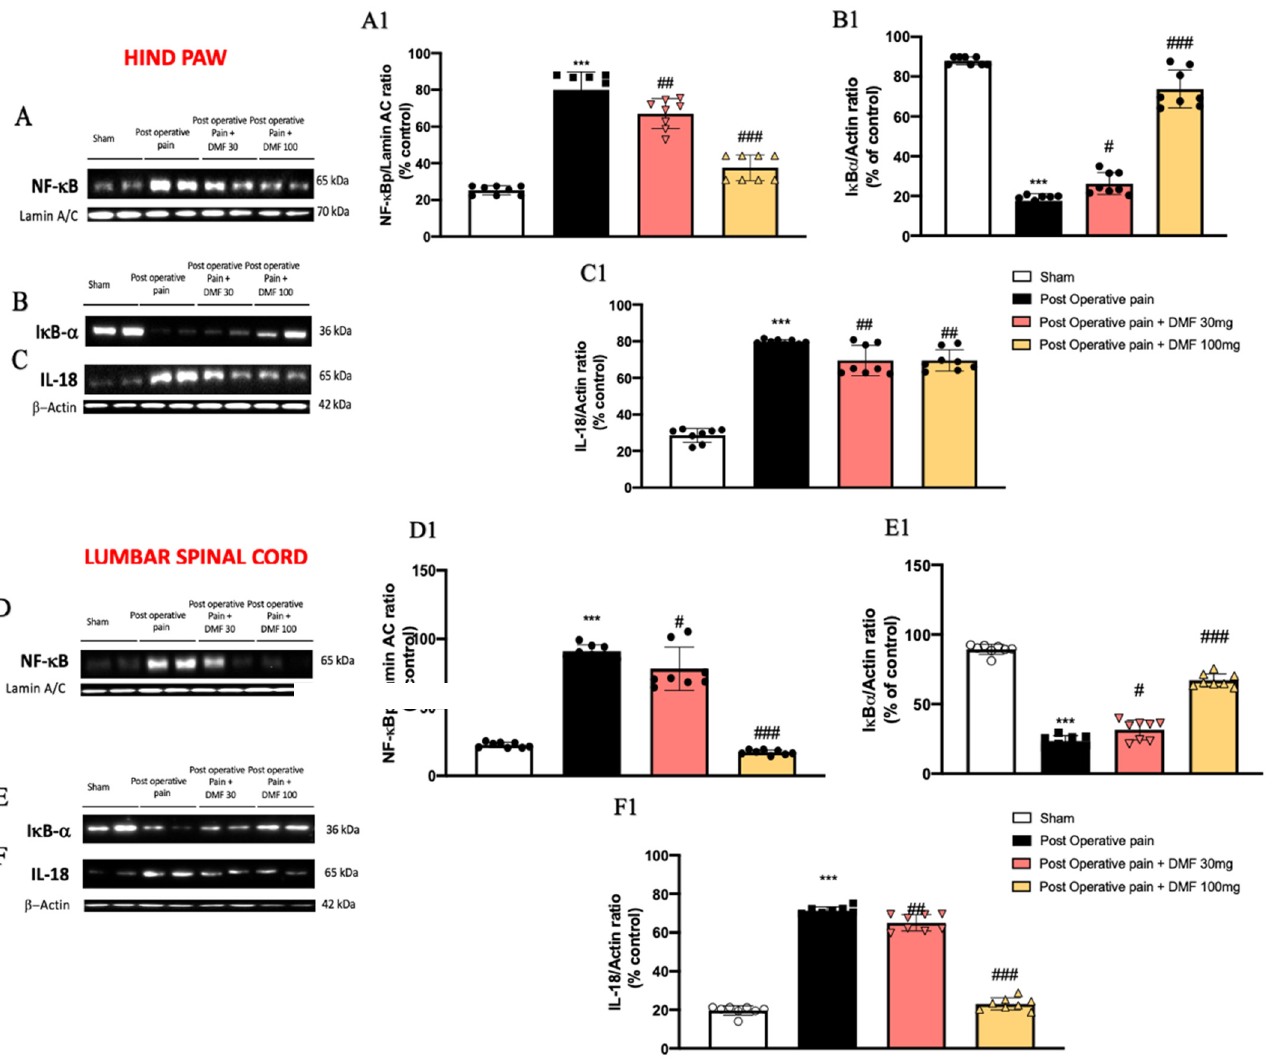
Figure 3. DMF treatment modulated NF- κ B pathway. Western blot analysis on hind paw samples of: nuclear NF- κ B expression ( A , A1 ), cytosolic I κ B- α ( B , B1 ) and IL-18 ( C , C1 ) expression. Western blot analysis on lumbar spinal cord samples of: nuclear NF- κ B expression ( D , D1 ), cytosolic I κ B- α ( E , E1 ) and IL-18 ( F , F1 ) expression. A p -value of less than 0.05 was considered significant; *** p < 0.001 vs. sham, ### p < 0.001, ## p < 0.01 and # p < 0.05 vs. PO pain.